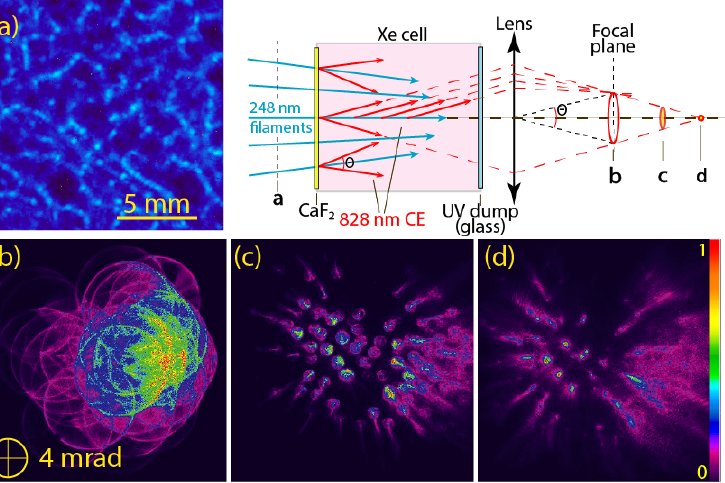
Figure 2. Layout of optical measurements along with the luminescence images of ( a ) UV filaments entering the cell; ( b – d ) IR CE in the lens focal plane and behind the focus, positions are indicated in the scheme of